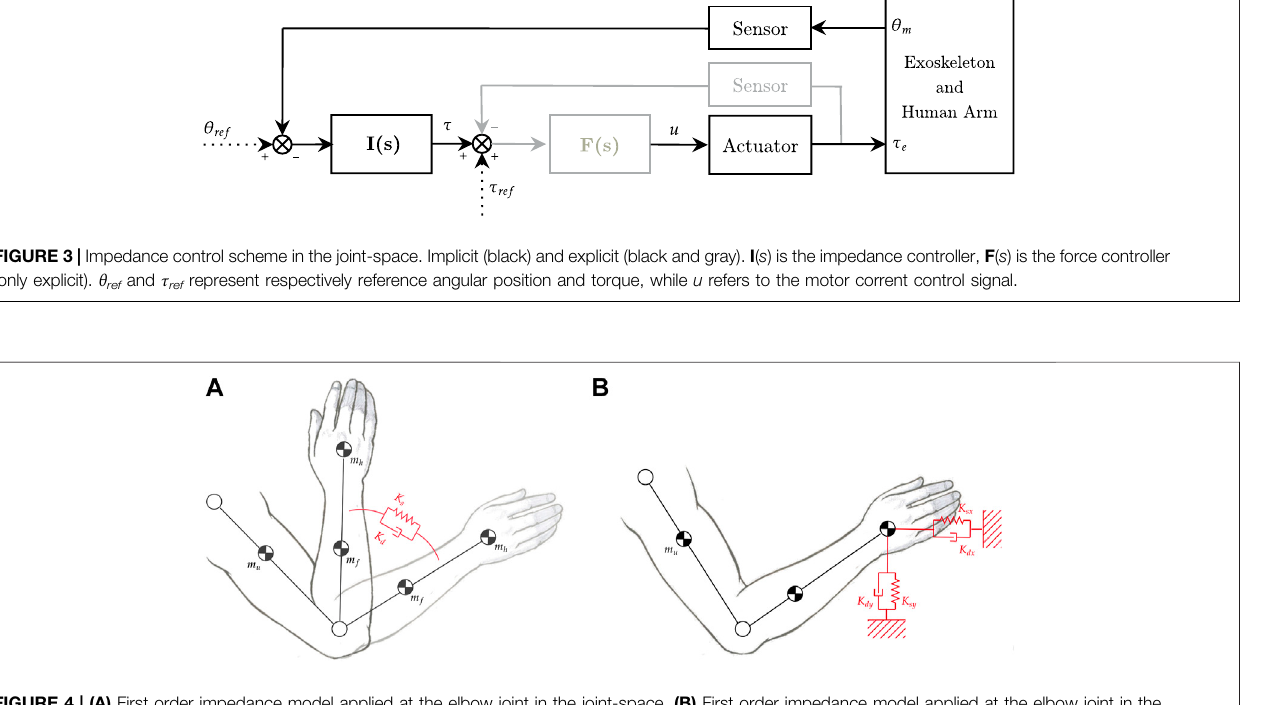
Frontiers in Robotics and AI |